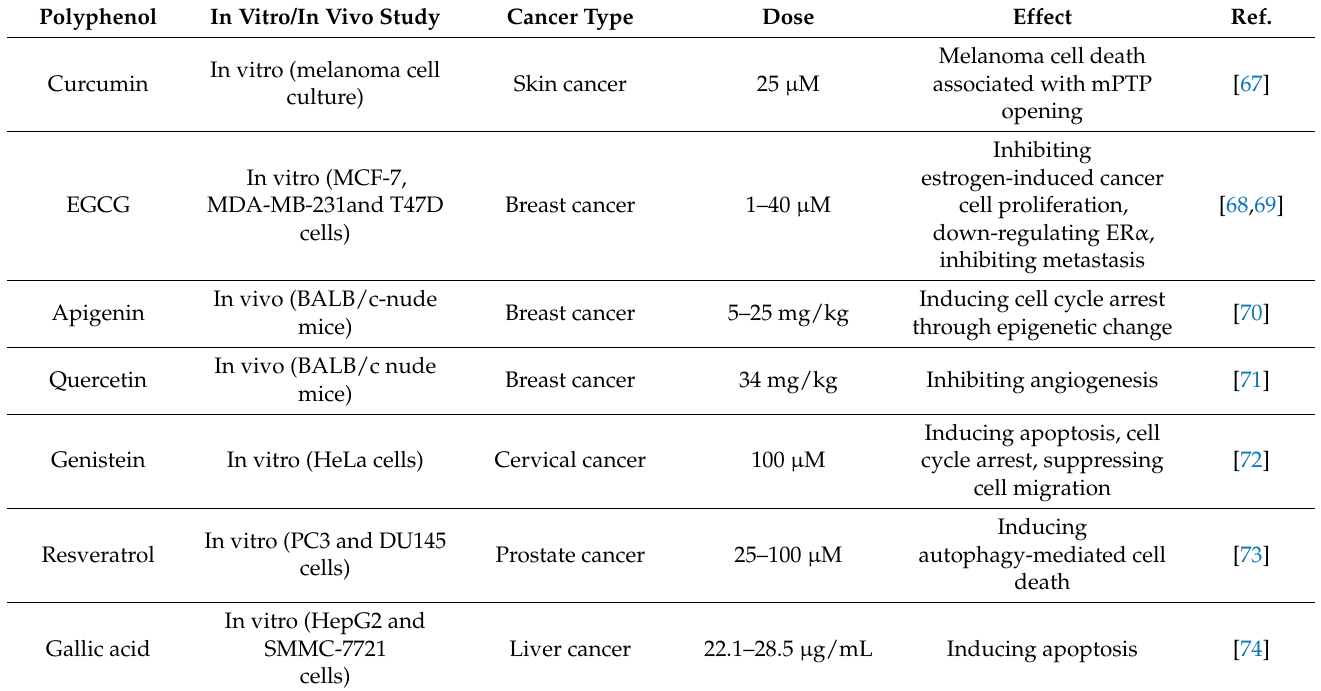
Table 2. The effects of polyphenols on various cancers